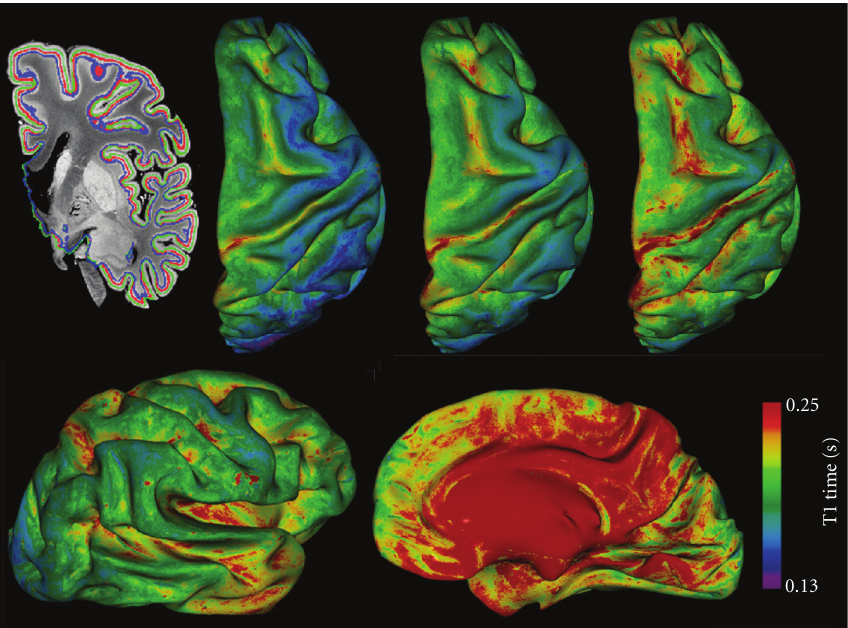
Figure 9: Top row: T1 times mapped onto inflated cortical contours extracted at 75%, 50% and 25% cortical depth (left to right) from the pial surface. The contours are outlined on a coronal view of an MR image in blue, red and green respectively. Bottom row: lateral and medial view of the T1 times at 25% cortical